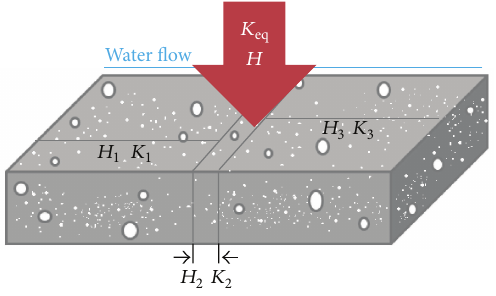
Figure 2: Water flow in REV with cold